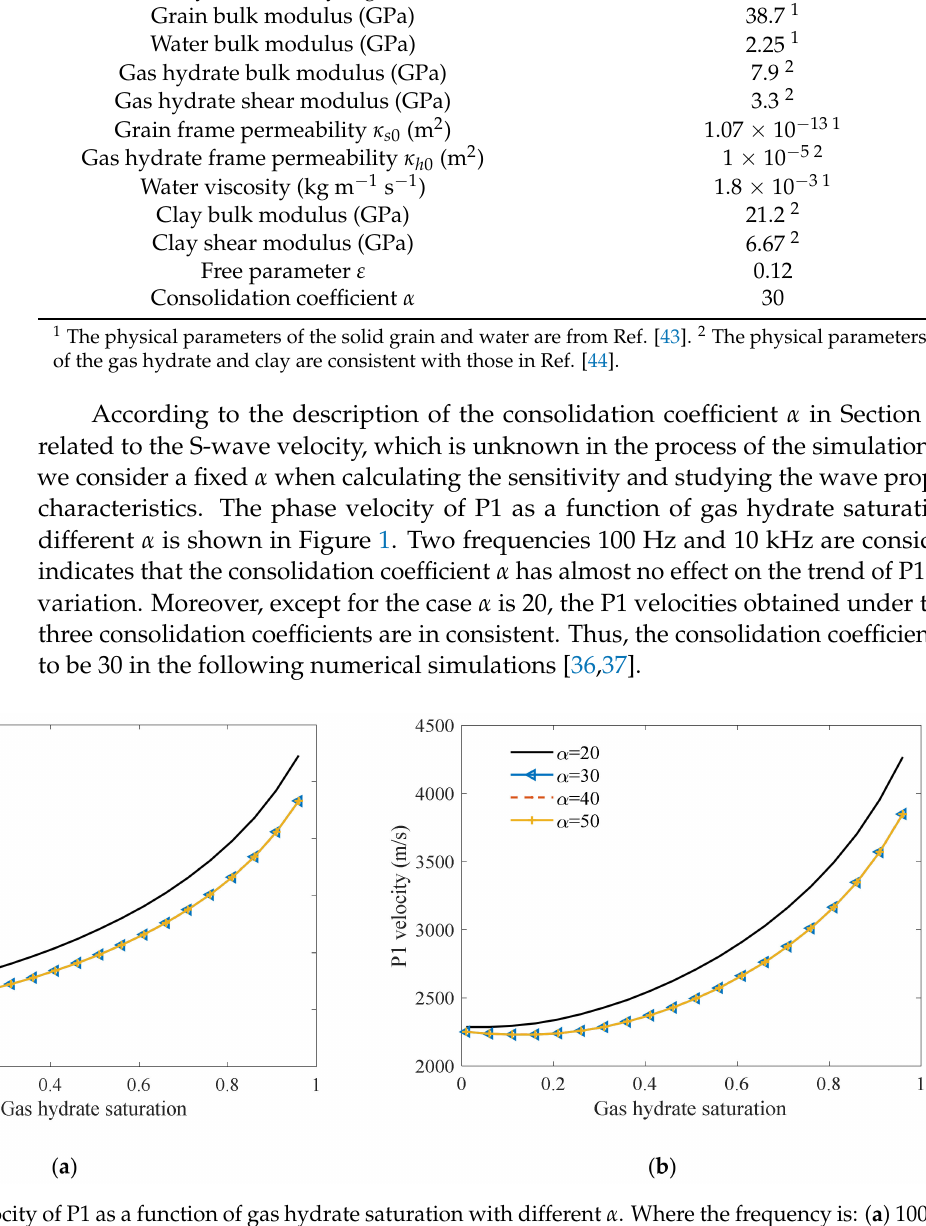
Figure 1. The phase velocity of P1 as a function of gas hydrate saturation with different α . Where the frequency is: ( a ) 100 Hz; ( b ) 10